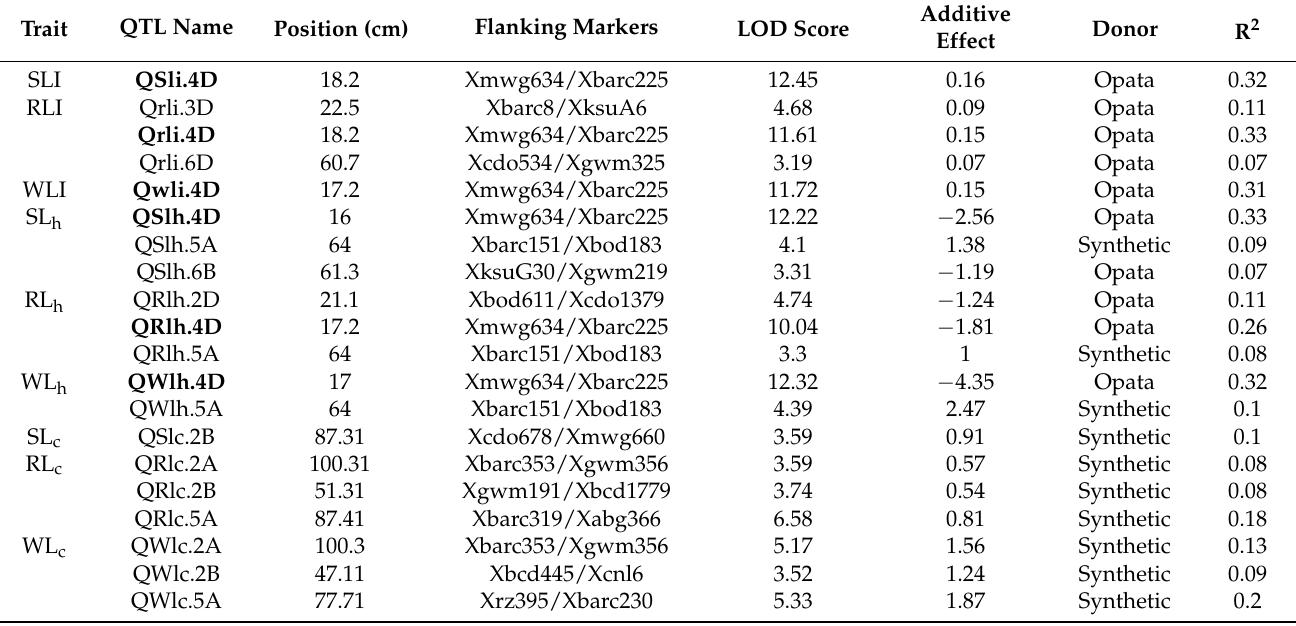
Table 2. QTL identified under heat stress and control conditions in a Synthetic W7984/Opata M85 recombinant inbreeding